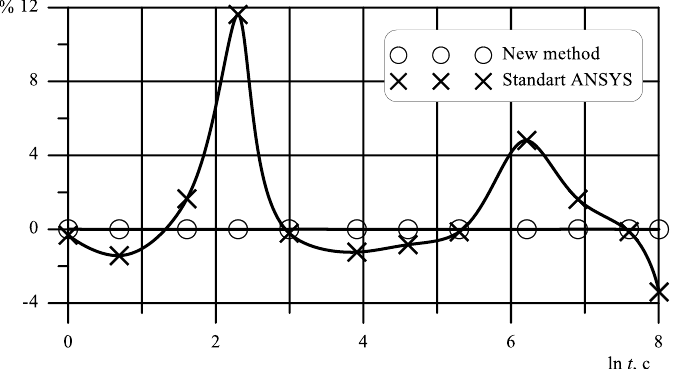
Fig. 7. Relative discrepancy between solutions of the stretching problem obtained by different methods relative to the analytical method